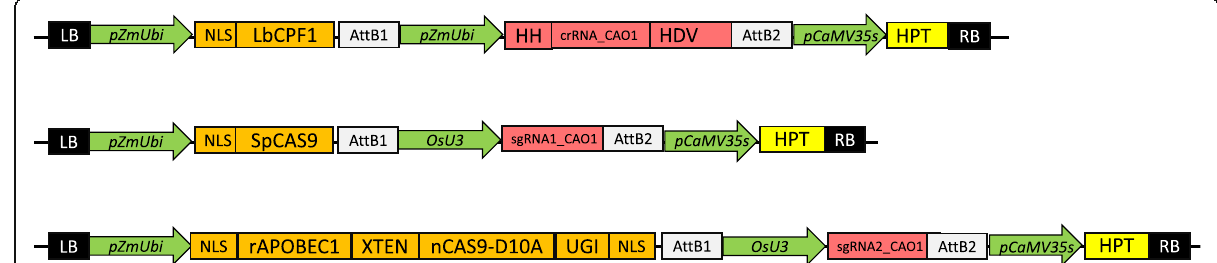
Fig. 1 Binary plasmids used. From top to bottom. Binary plasmid containing the LbCPF1 sequence (Tang et al. 2017) codon-optimized for rice, under the control of the promoter pZmUBI; crRNA-CAO1 was also under the control of a pZmUBI promoter. The plant resistance marker was hygromycin. Binary plasmid containing SpCAS9 (Miao et al. 2013) codon-optimized for rice under the control of the pZmUBI promoter. sgRNA- CAO1 was under the control of the rice promoter pOsU3. The plant resistance marker was hygromycin. Plasmid containing BEnCAS9 (Zong et al. 2017) codon-optimized for rice (available on Addgene: #98163), formed by a fusion of the rat rAPOBEC1 protein (Komor et al.), the XTEN linker, the nCAS9 nickase having a mutation inactivating the catalytic domain RuvC (D10A) and the UGI protein. The original cloning sites were replaced by AttR Gateway recombination sites. sgRNA-BECAO1 targeting exon 3 of the OsCAO1 gene was under the control of the rice pOsU3 promoter. HDV: HDV ribozyme; HH: Hammerhead ribozyme. All spacers were first cloned into entry vectors and then transferred to the binary vectors by